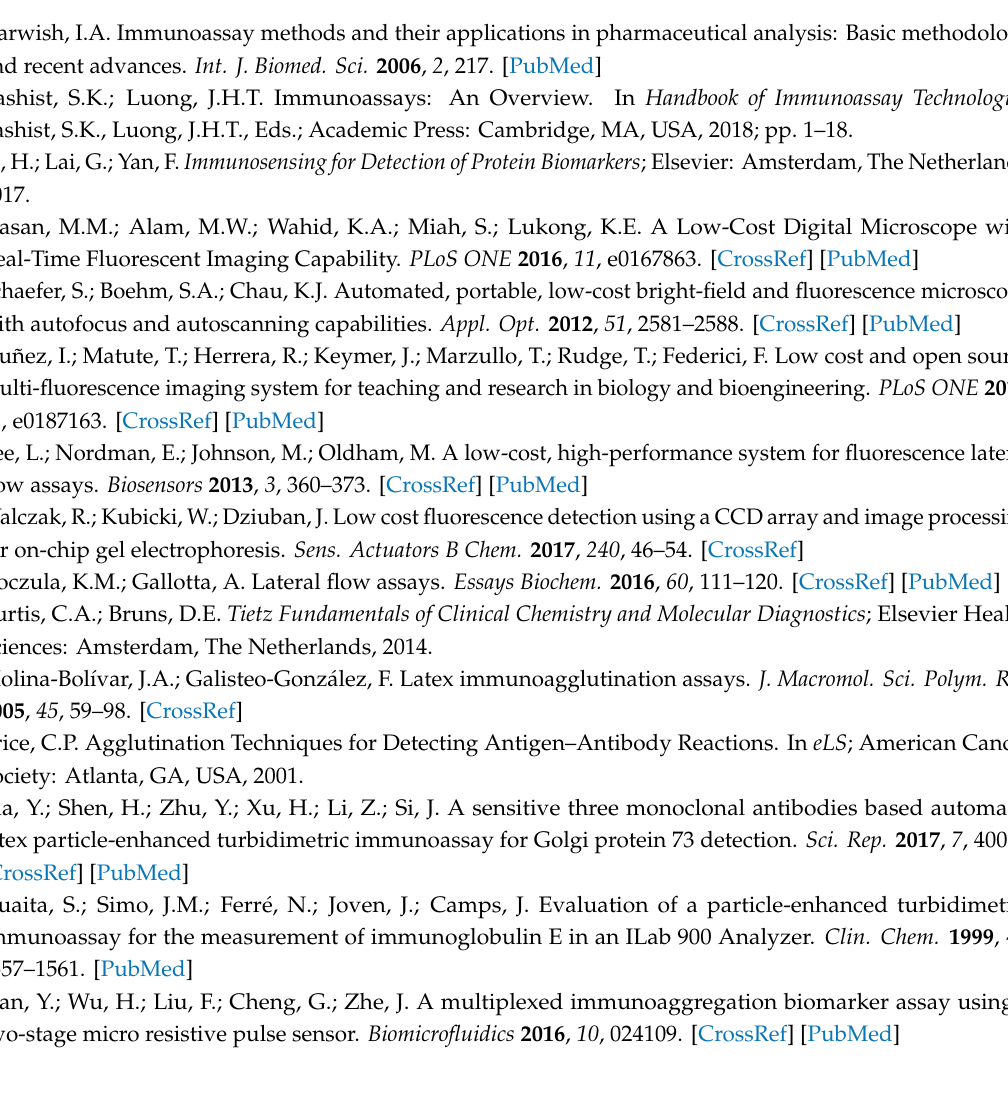
Figure S1: Photograph of the nephelometric system. Table S1: Results of experiments to evaluate the precision of